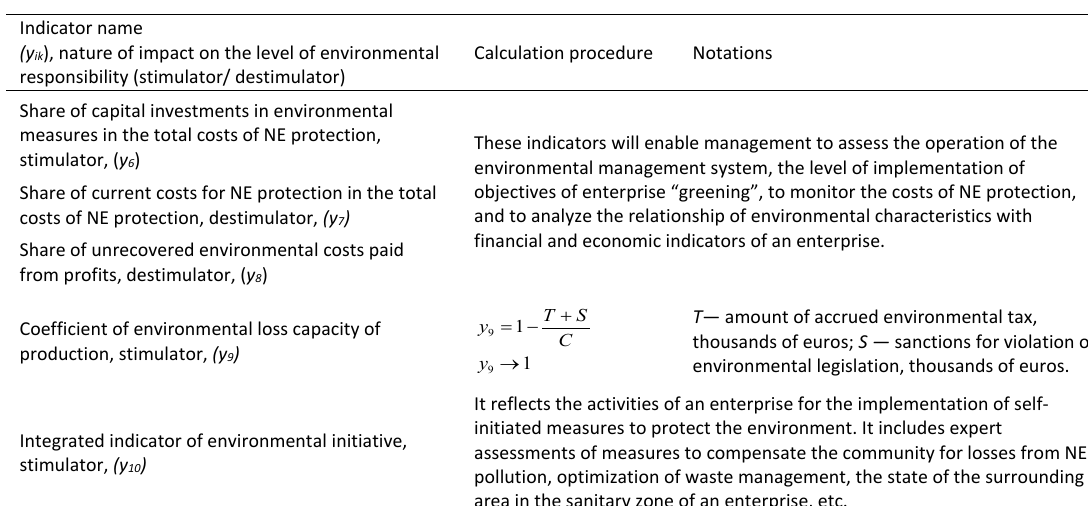
Table 3: Indicators for assessing the level of environmental responsibility of industrial enterprises — block of environmental initiative Indicator name (y ik ), nature of impact on the level of environmental responsibility (stimulator/ destimulator)